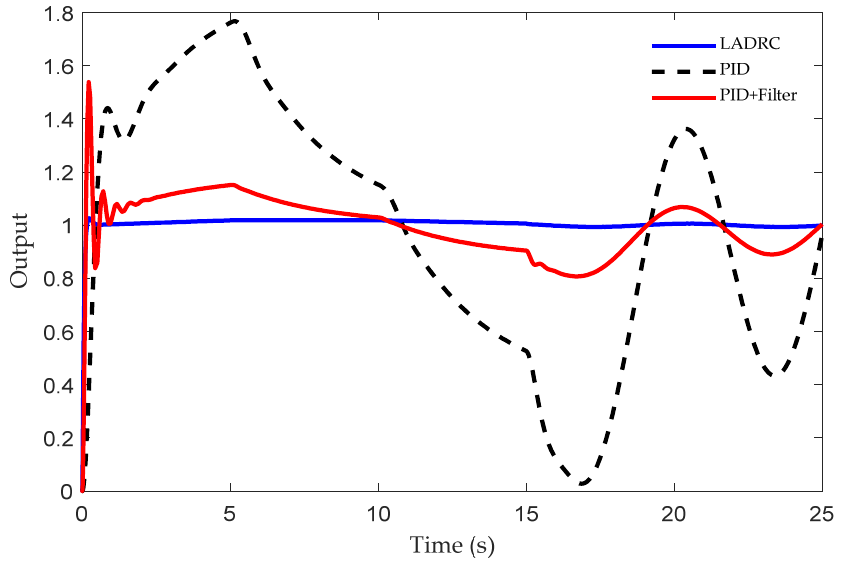
Figure 10. Simulation results of disturbance observer.